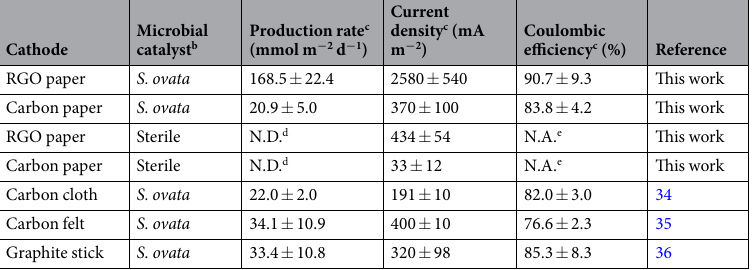
Table 1. Comparison of MES performances with different freestanding carbon-based cathodes under similar operating conditions a . a MES at a cathode potential of − 690 mV vs SHE. b S. ovata is the wild type strain DSM- 2662. c Each value is the mean and standard deviation of three replicates. d Not detected. e Not applicable.